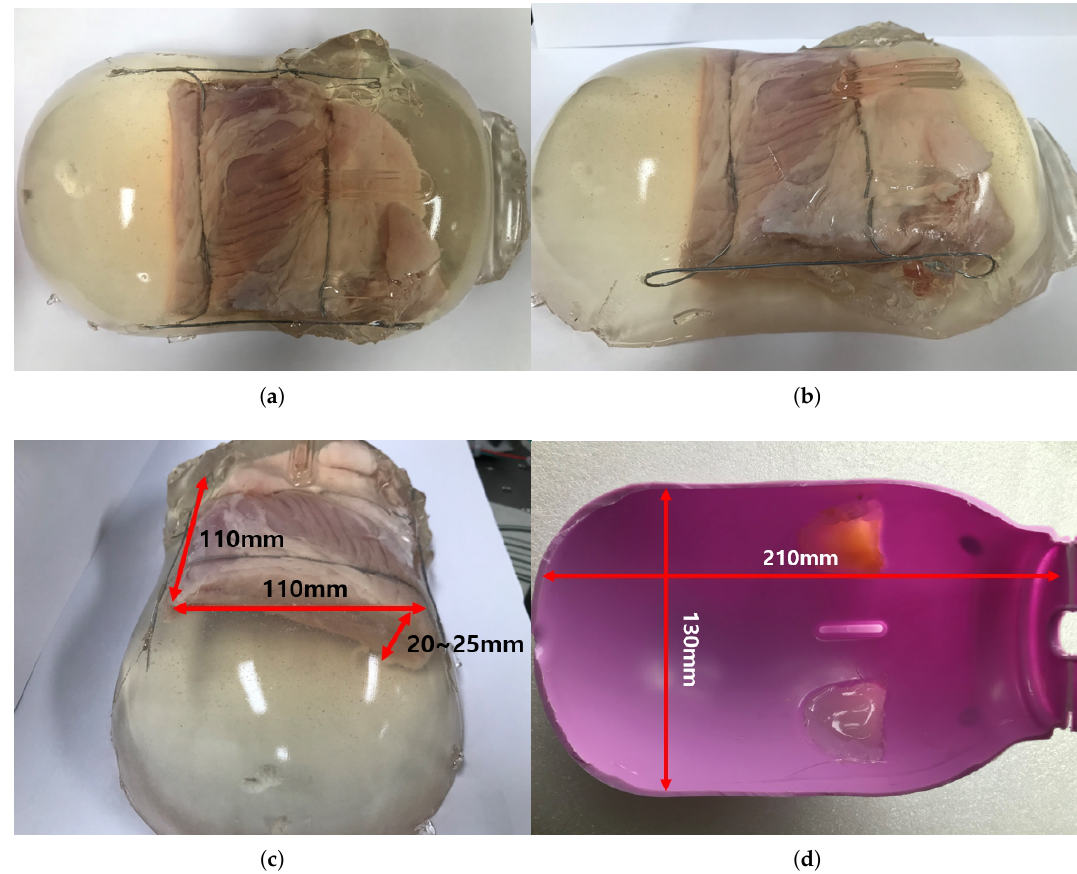
Figure 13. Ham-gelatin phantom for in-vitro test. ( a ) Ham-gelatin phantom (Plane view). ( b ) Ham-gelatin phantom (Side view). ( c ) Ham-gelatin phantom (Rear view). ( d ) Mold for Ham-gelatin